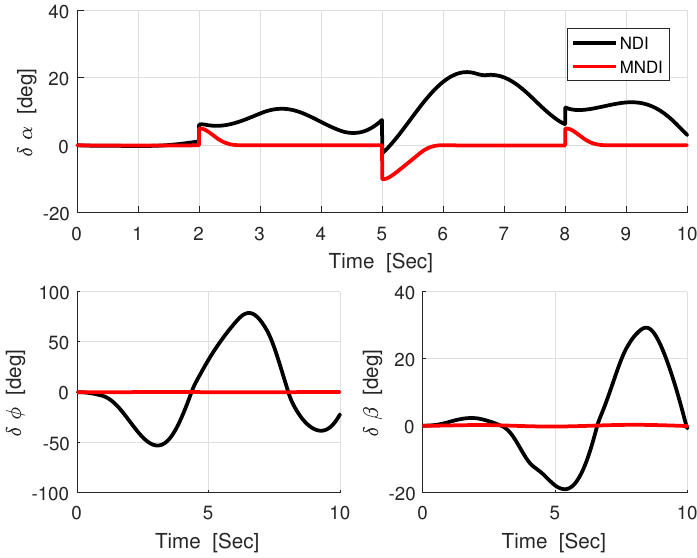
Figure 13. Attitude angle error for outer pitch angle excitation with wind and